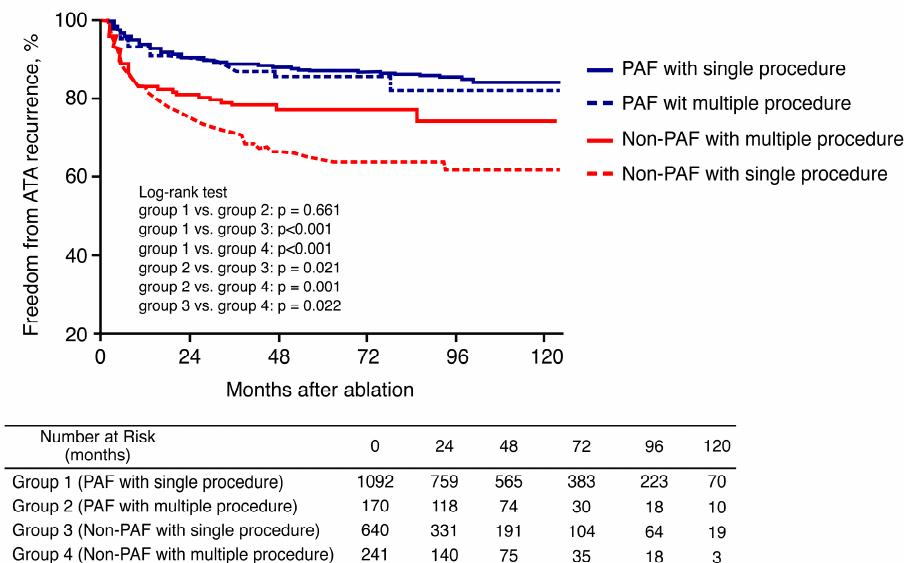
Figure 4. Kaplan–Meier curves showing ( A ) cumulative AF-free survival rates in patients with paroxysmal AF and non-paroxysmal AF and ( B ) AF-free survival rates in patients who underwent single and those who had multiple procedures.